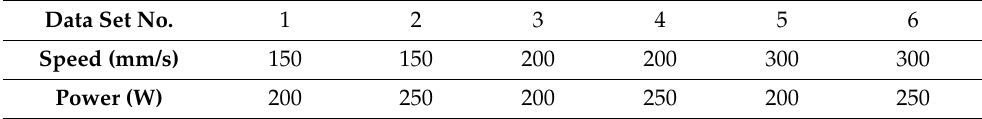
Table 1. LAM processing parameters for pure Ti Inconel 718 material.